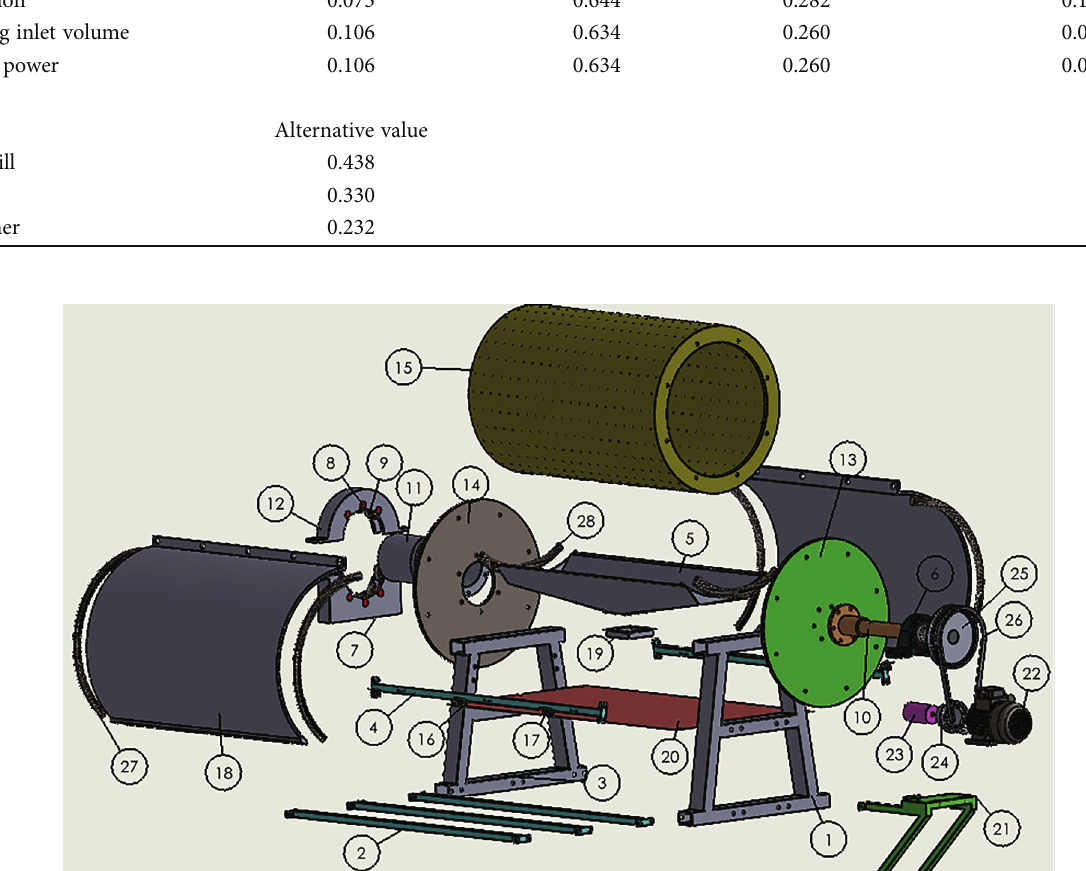
Figure 8: Exploded view of the